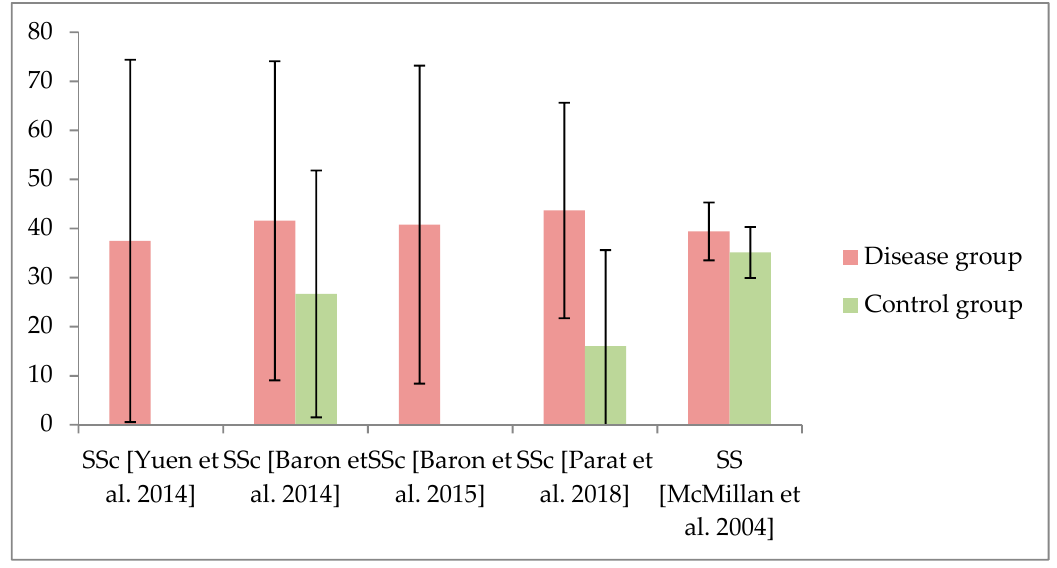
Figure 3. Findings of OHIP 49 in patients suffering from rheumatic diseases, including systemic sclerosis (SSc) and Sjögren syndrome (SS). For comparability, only studies presenting mean value ± standard deviation are displayed in this figure. If applicable, results of the control group are presented as well.3.4. OHRQoL Subscales